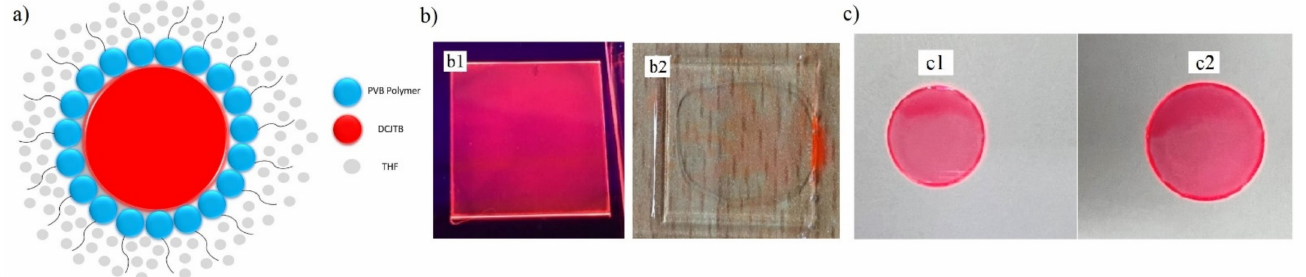
Figure 7. ( a ) PVB binding mechanism with the organic dye in the hybrid material system, ( b ) PVP- based red fluorescent film’s hydrophilicity: b1 and b2 represent the film before and after dipping into the water, respectively, and ( c ) PVB-based red fluorescent film’s hydrophobicity: c1 and c2 represent the film before and after dipping into the water, respectively.